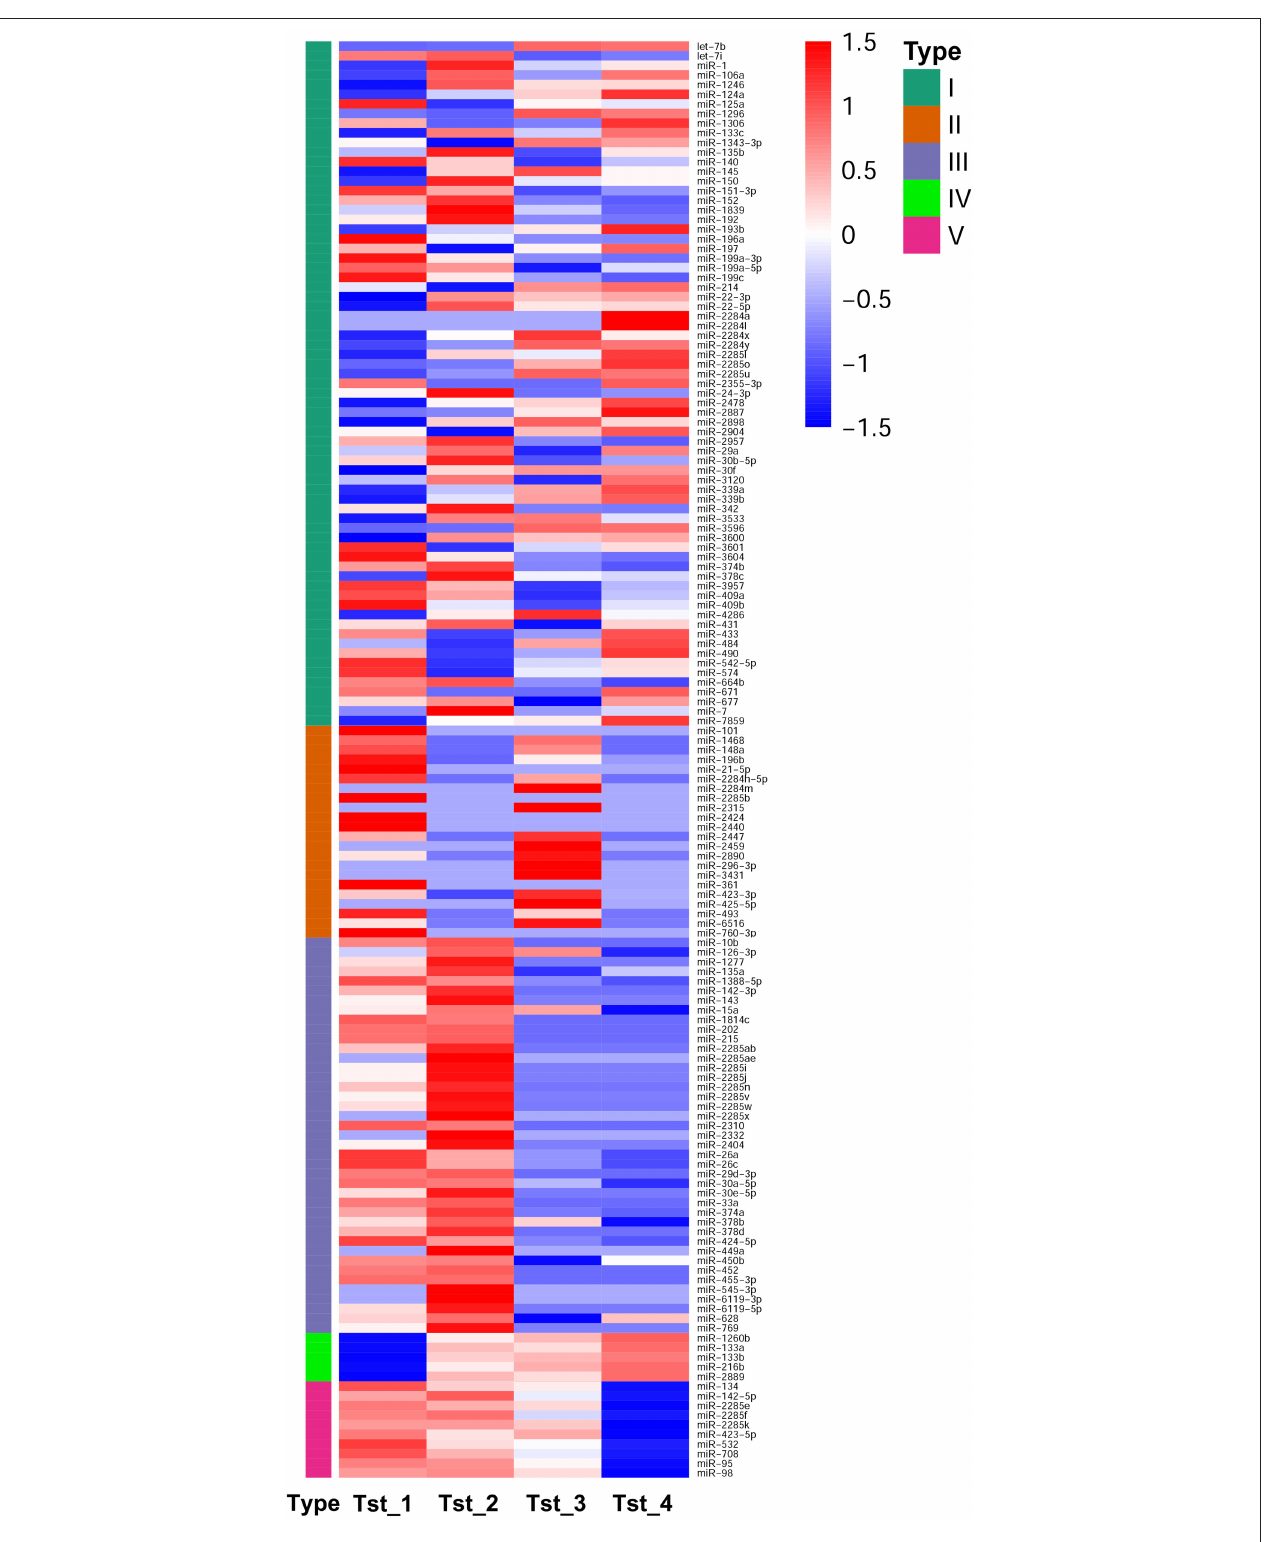
FIGURE 3 | Hierarchical clustering of DE